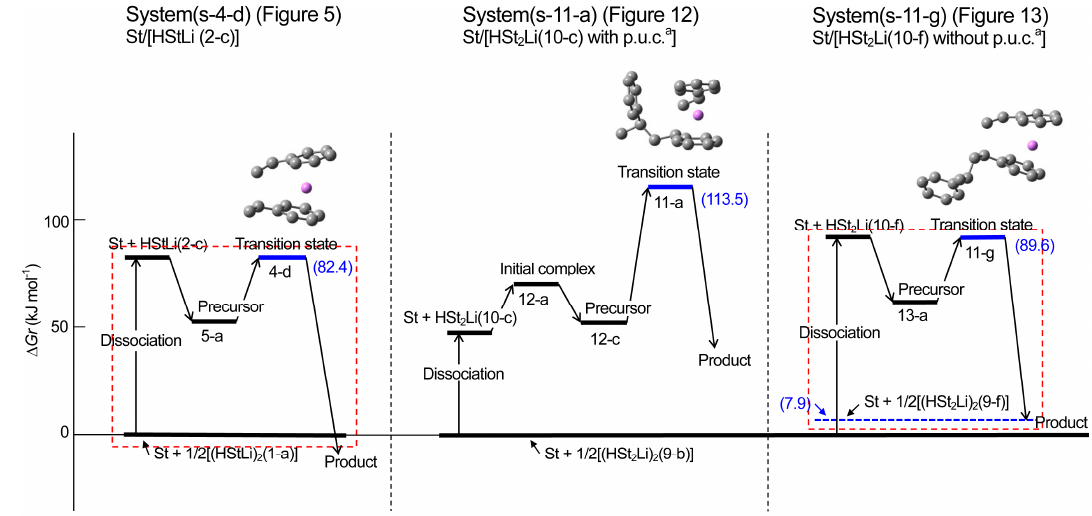
Figure 15. Free energy changes for the addition of styrene to HStLi and HSt 2 Li in the gas phase. The sub-transition state between the initial complex and the precursor for system(s-11-a) is not shown here. a p.u.c: penultimate unit coordination.